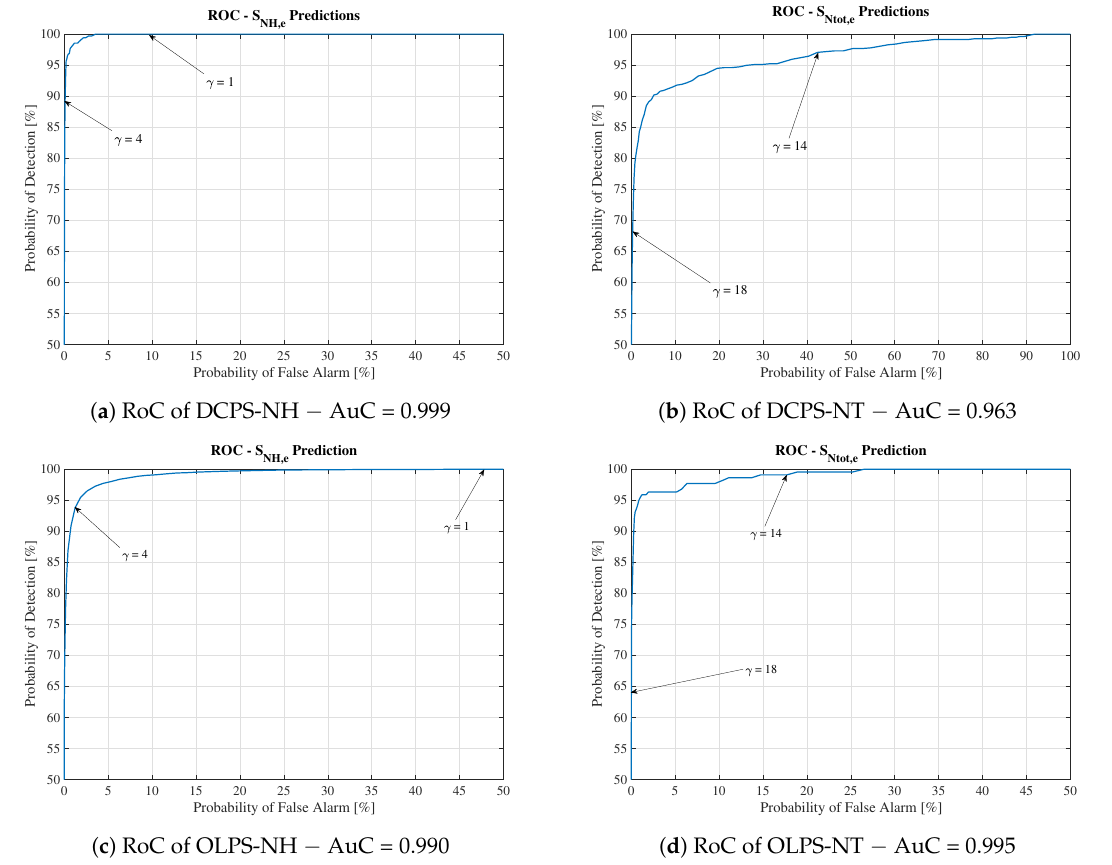
Figure 15. RoC curves for DCPS and OLPS